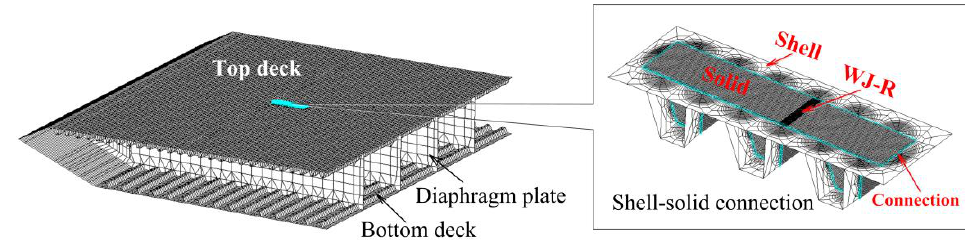
Figure 14. Multi-scale model of the Jiangyin Bridge.